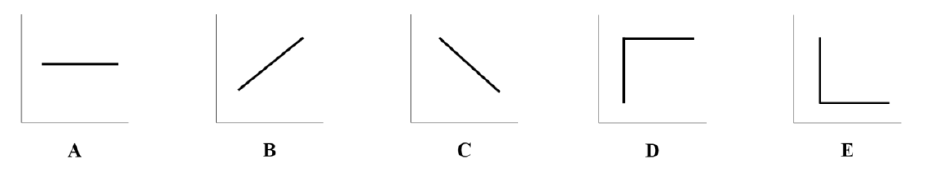
Figure 3. Five symbols to describe the trends of variables.